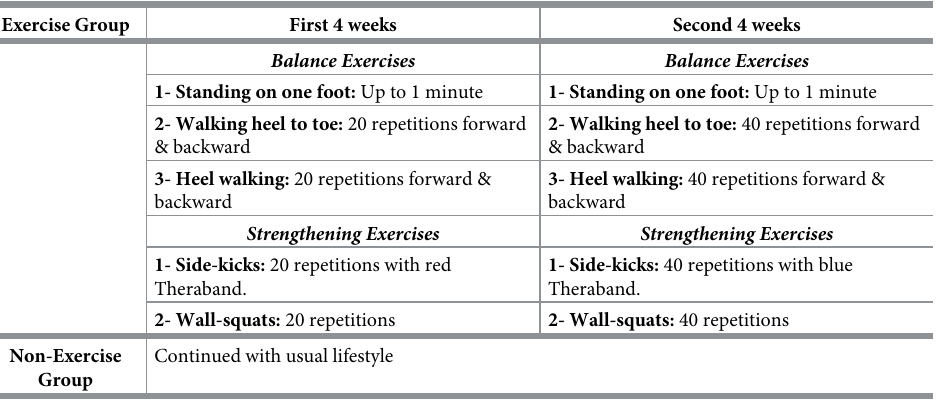
Table 1. Exercise